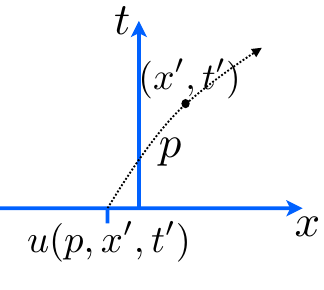
Figure 15: The function u ( p , x , t )